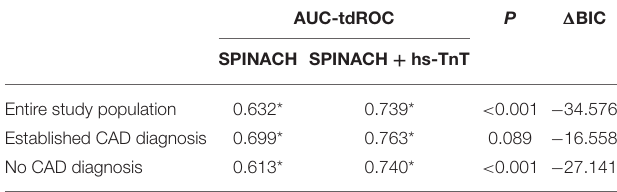
TABLE 3 | Prediction improvement with the addition of hs-TnT to SPINACH study